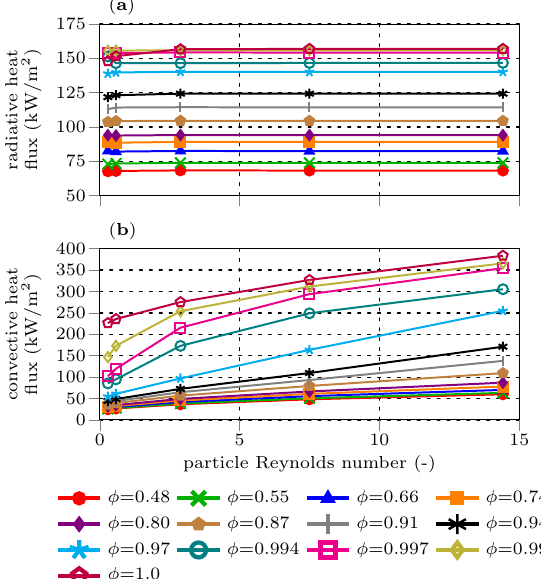
Figure 8. Comparison of specific radiative ( a ) and convective ( b ) integral heat flux towards the particle cluster versus the particle Reynolds number for different void fractions ( φ